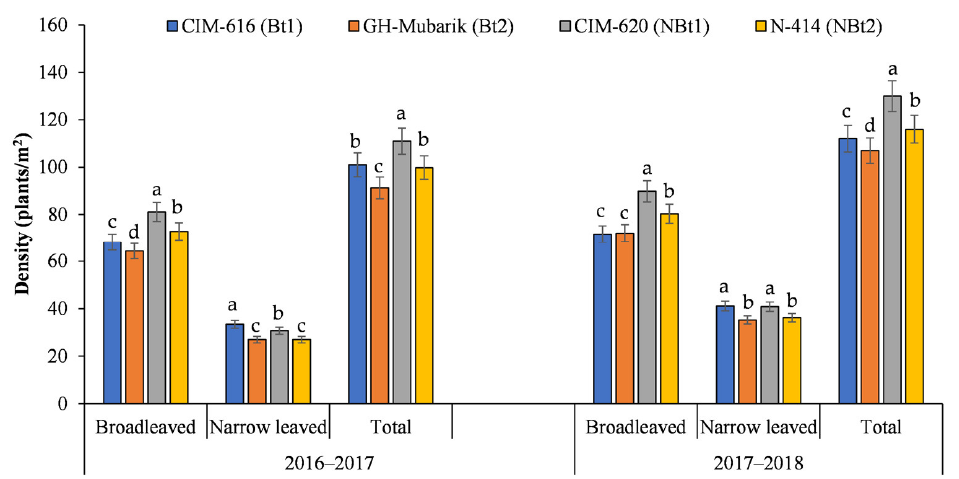
Figure 1. The densities (± standard errors of means, n = 3) of broadleaved, narrow-leaved, and total weed species recorded in different cotton genotypes. Here, Bt and NBt stand for Bt and non- Bt genotypes.